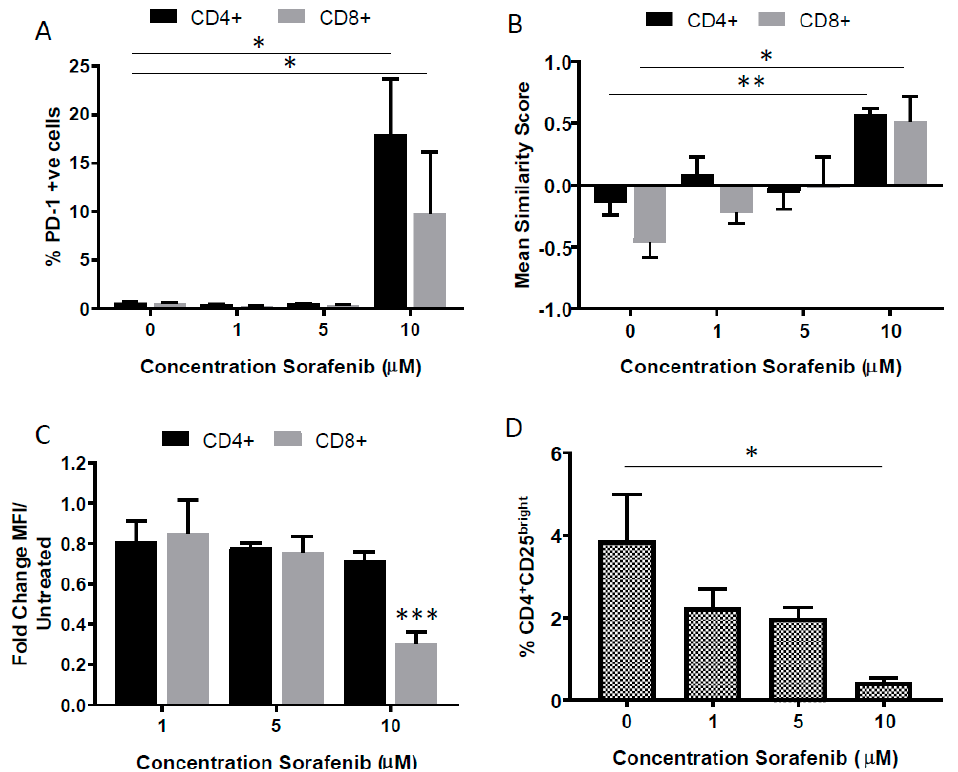
Figure 2. High dose sorafenib a ff ects PD-1 expression on T cells. ( A ) % PD-1 + CD4 + cells (black bars) and % PD-1 + CD8 + cells (grey bars) increases with high dose sorafenib (10 µ M), measured by imaging flow cytometry, ( B ) These PD-1 + cells exhibit an increased NFAT1 nuclear localization (measured by mean similarity score), ( C ) These PD-1 + cells exhibit an decreased CD8 + protein expression with high dose sorafenib (10 µ M), ( D ) the % CD4 + CD25 bright cells, as a % of total CD4 + cells decreases. Experiments are n = 3, * p < 0.05, ** p < 0.01, *** p < 0.001 by Student’s t -test.